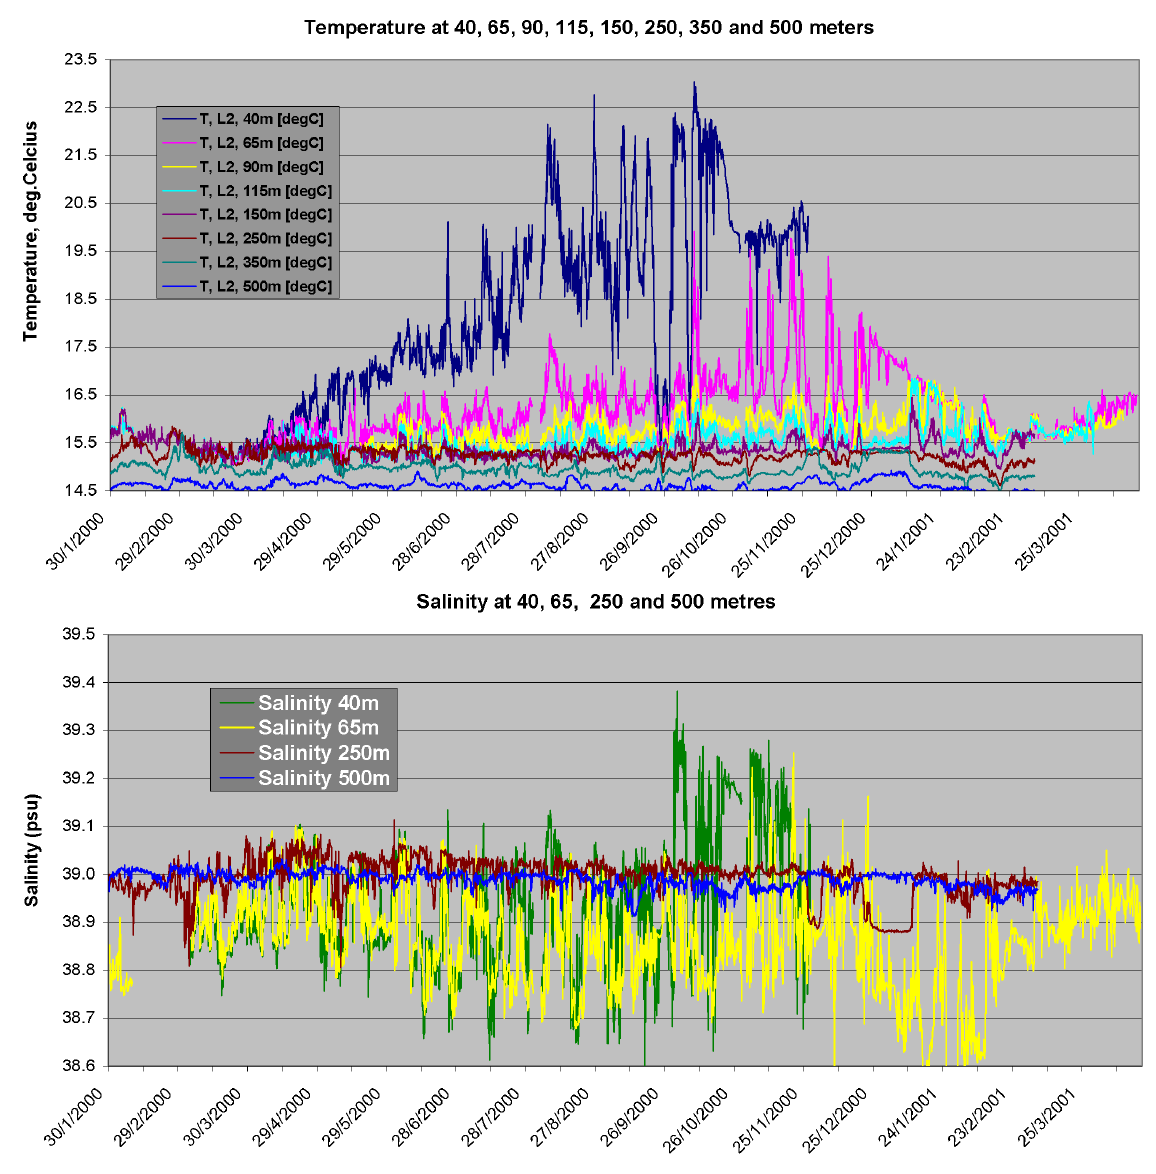
Fig. 8. Time series of temperature and salinity at 8 and 4 depths,